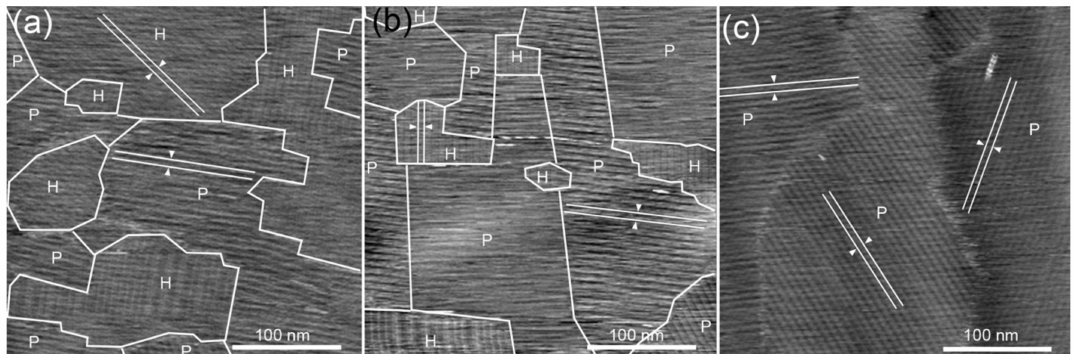
Figure 3. Morphological changes observed after annealing at 50 ◦ C. ( a ) Typical STM image showing coexistence of H and P arrangements in the PCDYol film prepared by quasi-LB ( I set = 6 pA, V bias = 800 mV, 3.6 Hz). Domain boundaries are indicated by white lines. The area ratio of P arrangement is 0.4. The stripe intervals of H and P arrangements are suggested by pairs of white lines. ( b , c ) STM images of the film after annealing at 50 ◦ C for ( b ) 300 s ( I set = 6 pA, V bias = 800 mV, 3.6 Hz) and ( c ) 3600 s ( I set = 10 pA, V bias = − 500 mV, 3.6 Hz).